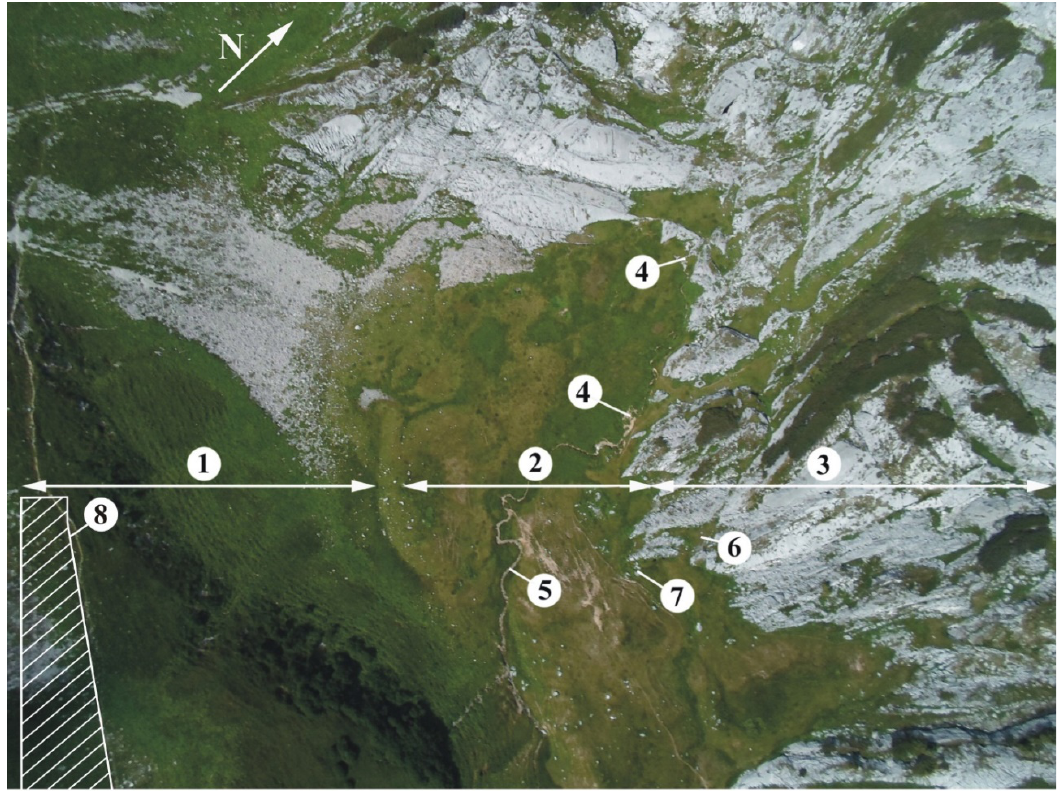
Figure 12. Aerial photograph of the area of paleouvala, which is under Wildgössl (Totes Gebirge, photo taken by Kalm á r). 1. side of paleouvala with debris fans, 2. floor of paleoouvala with superficial deposit, 3. slope of paleouvala with glacially eroded cuesta, 4. covered karst ponor, 5. gully, 6. covered karst terrain intruding into the depression of the cuesta, 7. a subsidence doline in the zone of thin superficial deposit next to rock boundary, 8. zone of